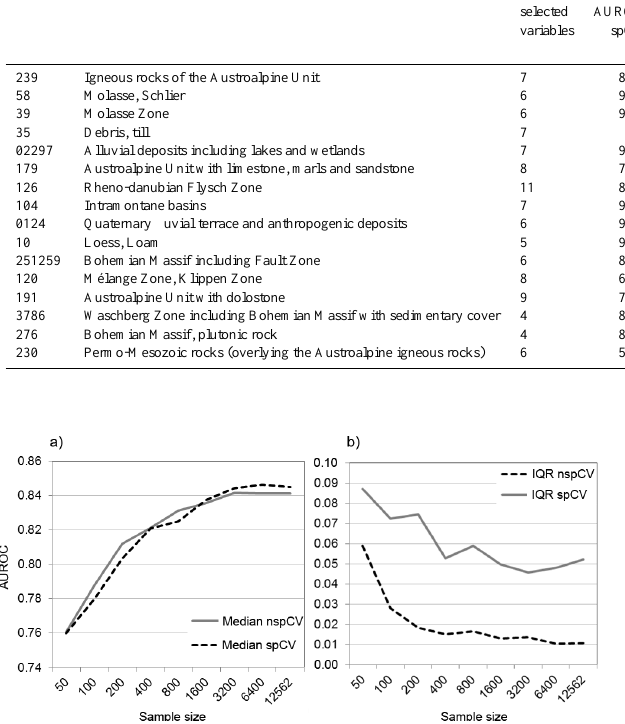
Fig. 6. (a) Median AUROC value and (b) interquartile range of AUROC values (IQR) at reduced sample sizes (numbers given refer to the total number of equally distributed landslide and non-landslide points) in the Flysch Zone (Domain 126) resulting from spatial cross-validation (spCV, grey line) and non-spatial cross-validation (nspCV, black dashed line).